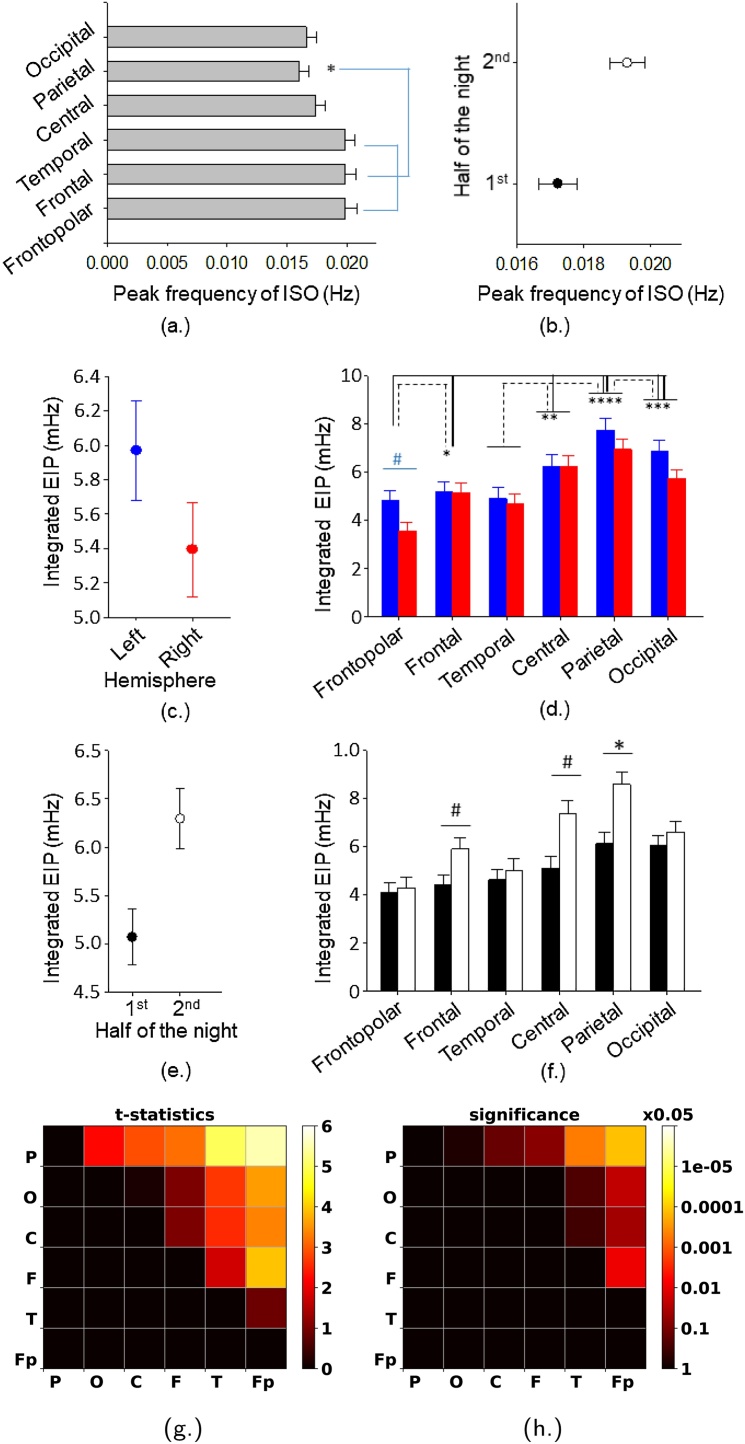
Frequency and power characteristics of infraslow oscillations (ISO) in fast sleep spindle activity (13–15 Hz) in continuous artefact-free NREM stage 2 sleep (34 subjects): effects of brain hemisphere, region and half of the night on peak frequency of infra slow oscillations (ISO) and integrated excess infra power (EIP)(see also Fig. 5). Analyses are controlled for the number of sleep spindles detected in the studied EEG segments and across each EEG derivations (a–f). Least square mean and SEM are indicated. (a) Effect of factor brain region on peak ISO frequency. (b) Effect of factor half of the night on peak ISO frequency. (c) Effect of factor hemisphere on integrated EIP. (d) Interaction between factor brain region and factor hemisphere. (e) Effect of factor half of the night. (f) Interaction between factor half of the night and brain region. Stars indicate significant (adjusted P < 0.05) and Tukey-Kramer adjusted post-hoc differences. Stars are indicated only at the second element included in the post-hoc comparison. Dashes indicate trends (adjusted P < 0.1). In interaction figures (d and f) significant post-hoc effects are indicated for differences between the brain regions (d and f), the two hemispheres (d) and the two halves of the night (f) but not for the combination of the two factors. Blue bars indicate left hemisphere and red bars right hemisphere (d). Black bars indicate first half of the night and white bars second half of the night (f). (g and h) One sample t-test of the integrated EIP (see inset in Fig. 5(b)) difference between all combinations of region pairs. Pairs in reverse order and self comparisons are omitted (in black). P-values beyond 0.05 also appear in black. Regions were ordered descendingly based on the integrated EIP.